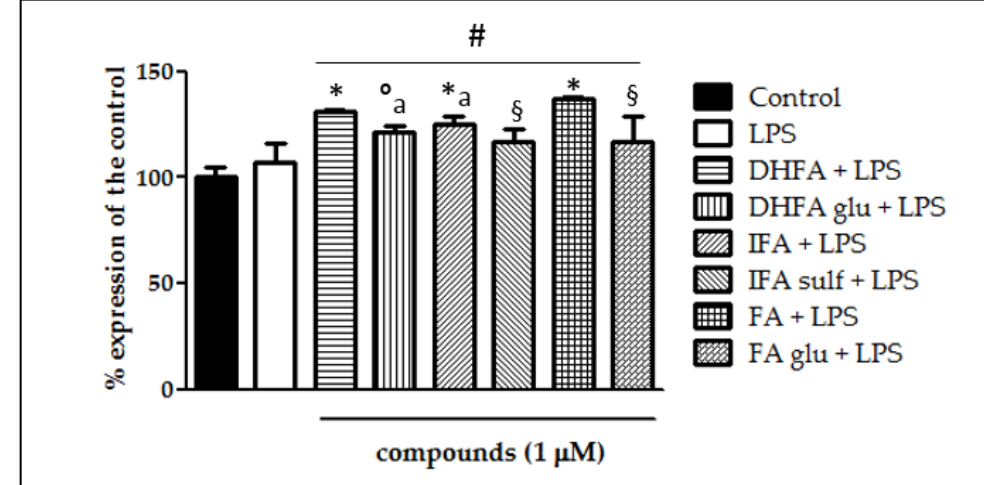
Figure 11. Expression of Nrf2 dosed by qRT-PCR and reported as a percentage of the control in Caco-2 cells treated with LPS (1 µ g/mL) for 6 h and pretreated for 30 min with FA, DHFA, IFA, FA glu, DHFA glu, and IFA sulf (1 µ M) preceding LPS co-exposure. Control and LPS groups were pretreated with an equivalent volume of methanol. Each column represents the mean ± SD of independent experiments ( n = 6). Significant differences among groups are described using different superscript symbols; # = significant vs. control ( p < 0.001); * = significant vs. LPS ( p < 0.001); ◦ = significant vs. LPS ( p < 0.01); § = significant vs. FA + LPS ( p < 0.001) and vs. DHFA + LPS ( p < 0.01); a = significant vs. IFA + LPS and DHFA glu + LPS ( p < 0.01).